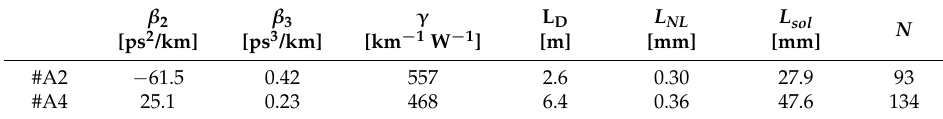
Figure 14. Numerically generated ( a , d ) supercontinuum spectra for in the range of 0.2–2.4 nJ, ( b , e ) evolution of the spectra as a function of the length of the fiber for E imp = 2.4 nJ, ( c , f ) time–delay spectrograms. The upper rower depicts the fiber #A2, while lower—#A4. Table 7. Nonlinear parameters for computer simulations in the fibers #A2 and #A4.